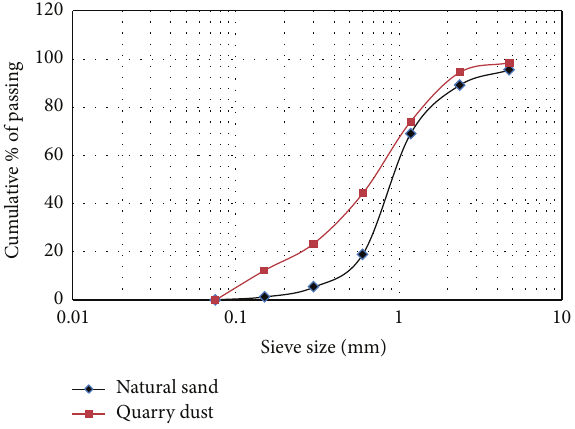
Figure 2: Sieve analysis of river sand and quarry